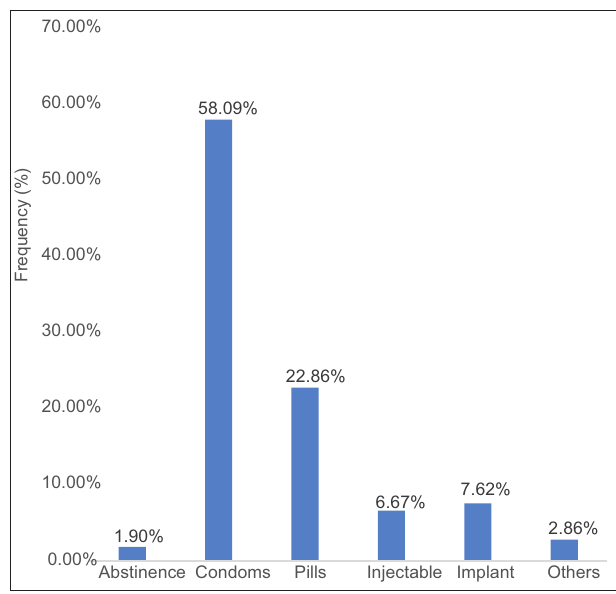
Figure 1: Types of contraceptives currently used by study participants